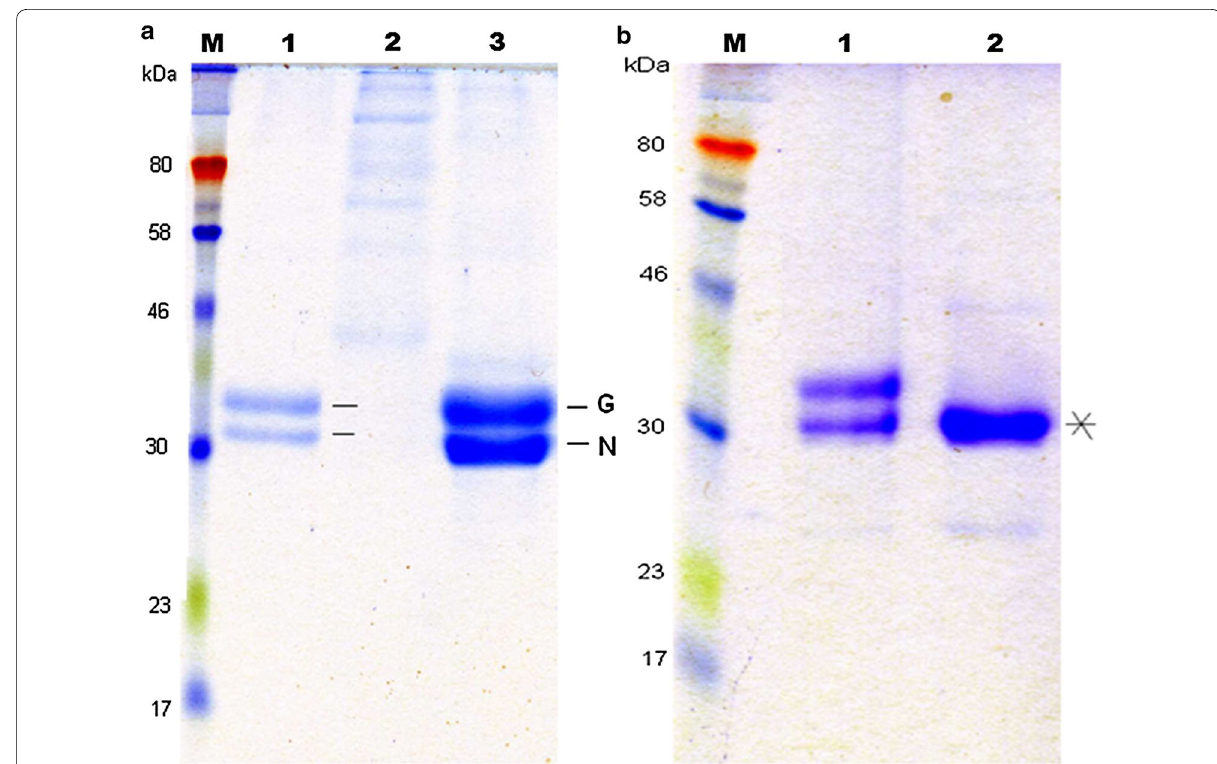
Fig. 2 SDS‑PAGE analysis of the extracellular extract from recombinants; a lane 1 X‑33/pGAPZα pGAM1 MCAP‑3. b Enzymatic analysis of the extracellular extract from X‑33/pGAM1 +